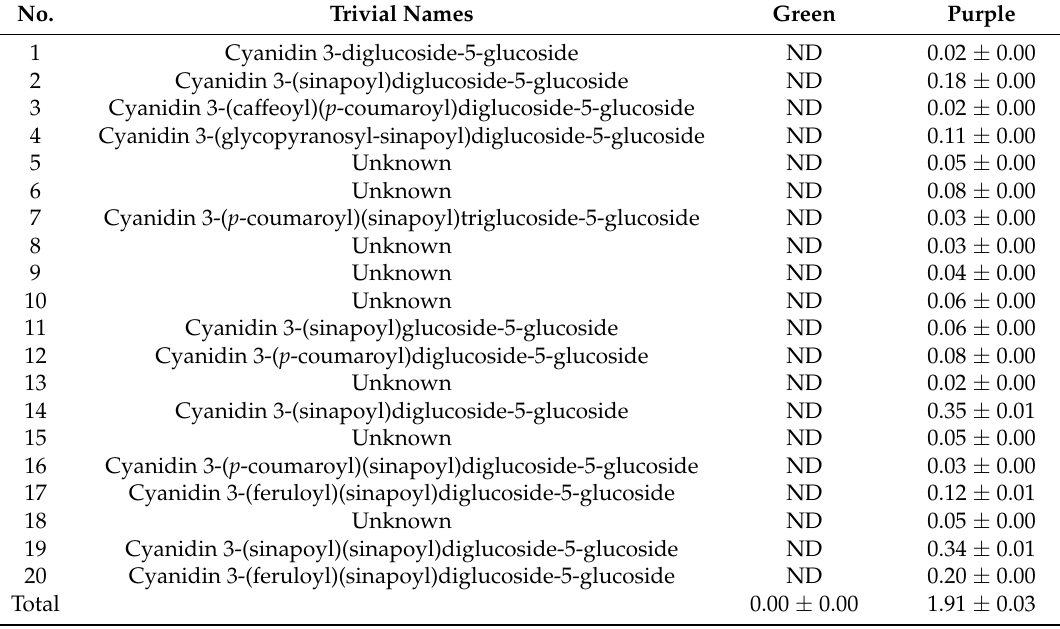
Table 2. Anthocyanin contents in green and purple pakchoi (mg g − 1 dry weight). No. Trivial Names Green